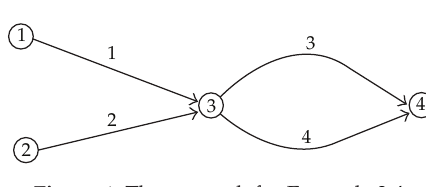
Figure 1: The network for Example 3.4. Table 1: OD pairs and path